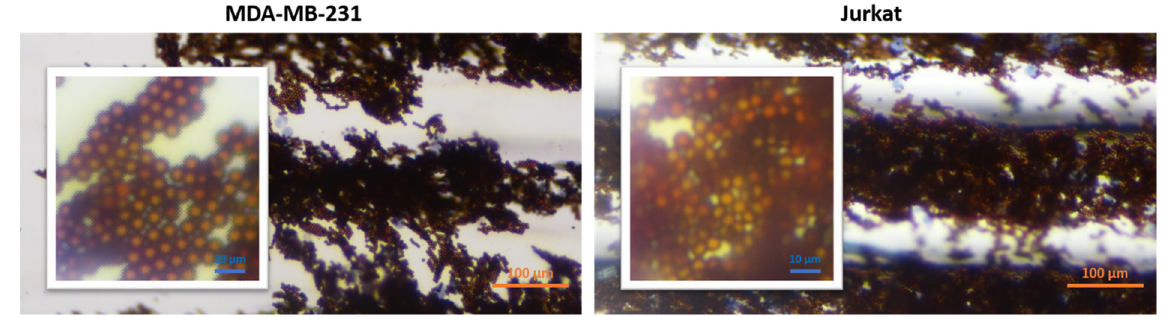
Figure 6. Last compartment microscopic images (10×) of Jurkat and MDA-MB-231 cell lines. Inset images show a close view of the original images.